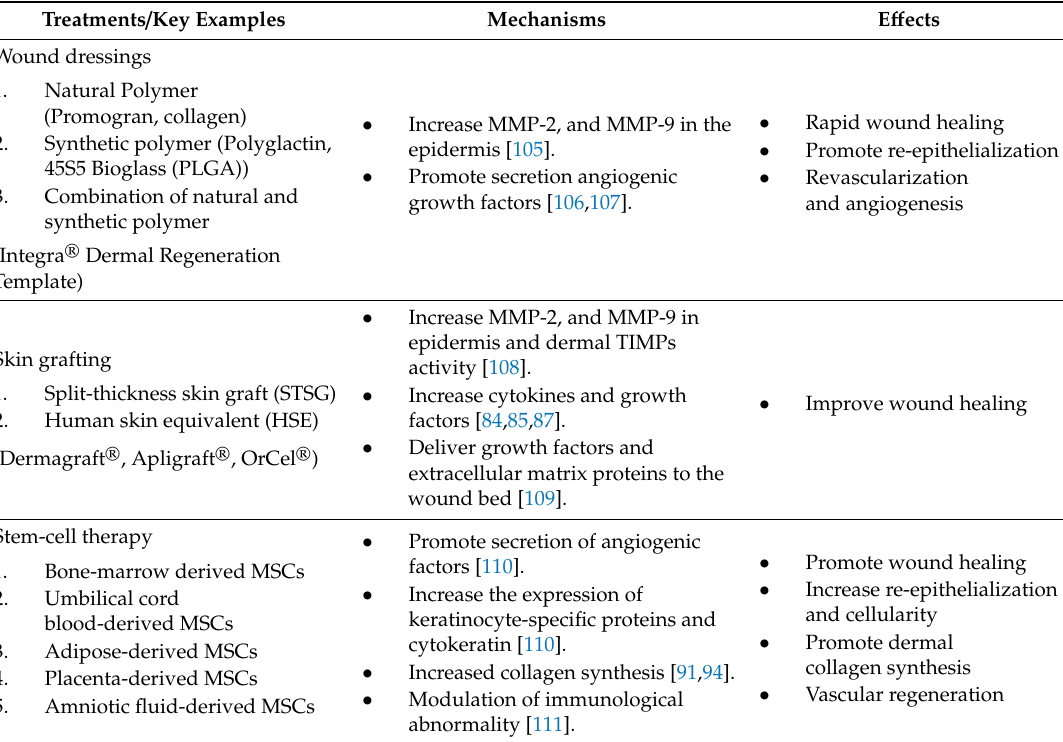
Table 1. Current and experimental treatments for